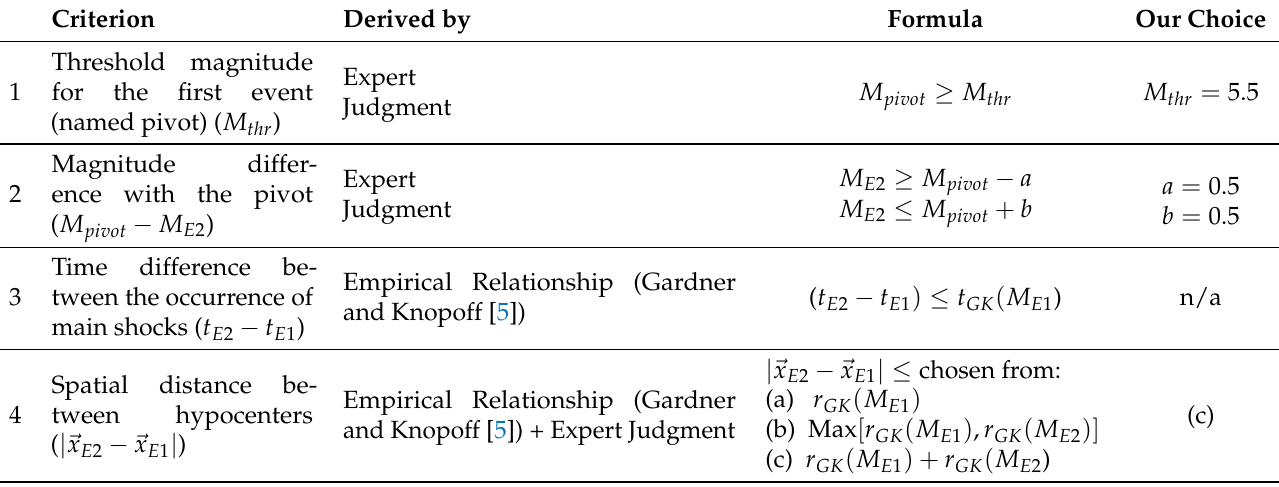
Table 1. Constitutive criteria for our clustering analysis algorithm. For each criterion, the second column shows rationale on which it is based, the third column contains formulas, and the last column contains choices used in this